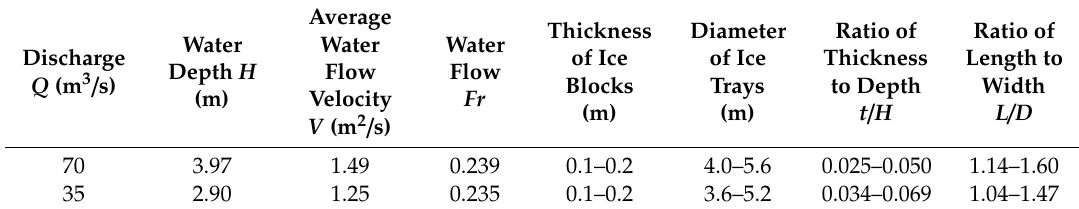
Table 1. Flow and ice parameters of the